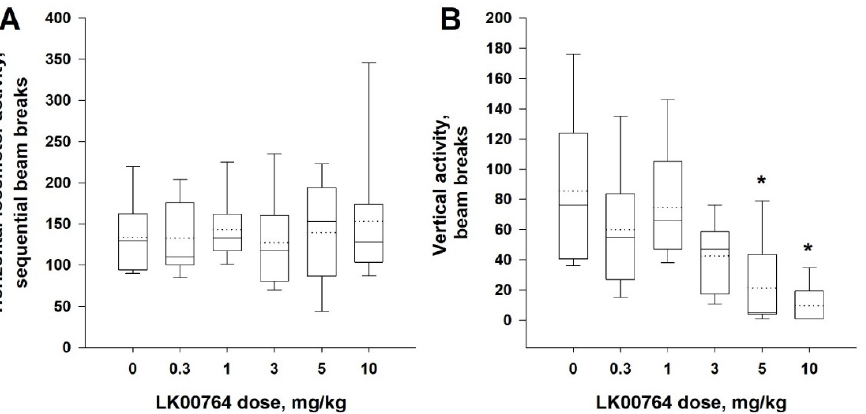
Figure 5. Effect of compound 62 (LK00764) locomotor activity of intact rats. The pretreatment with compound 62 (LK00764, 0.3–10 mg/kg, i.p.) did not affect horizontal ( A ), but dose-dependently decreased vertical, activity ( B ) of intact rats. Data are represented as medians (solid lines), means (dotted lines), and 25th and 75th percentiles in a box-whisker plot, with whiskers indicating 10th and 90th percentiles. * p < 0.05 (Dunnett’s test) compared to the vehicle ‐ treated rats (n = 9).